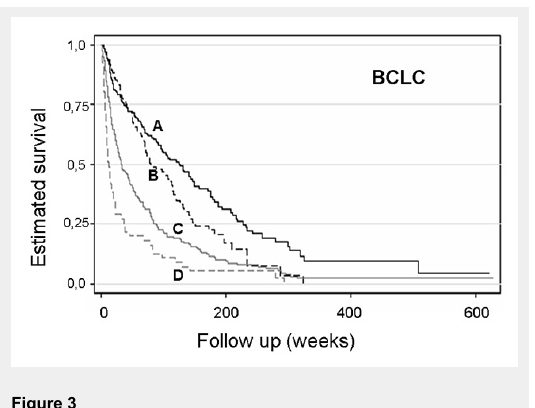
Figure 4 Kaplan-Meier curve for survival by CLIP score in patients with hepatocellular cancer (n = 131, 155, 98, 51, 29, 17 and 3 for CLIP 0‒6, respectively). CLIP = cancer of the liver Italian programme